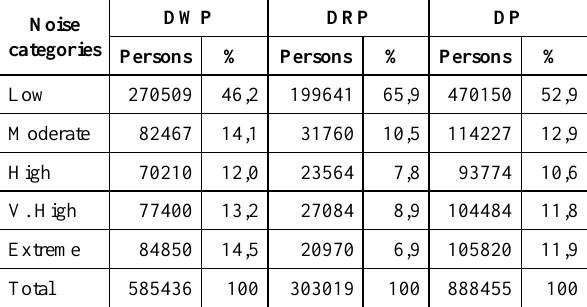
Table 5. Exposure of daytime worker (DWP),